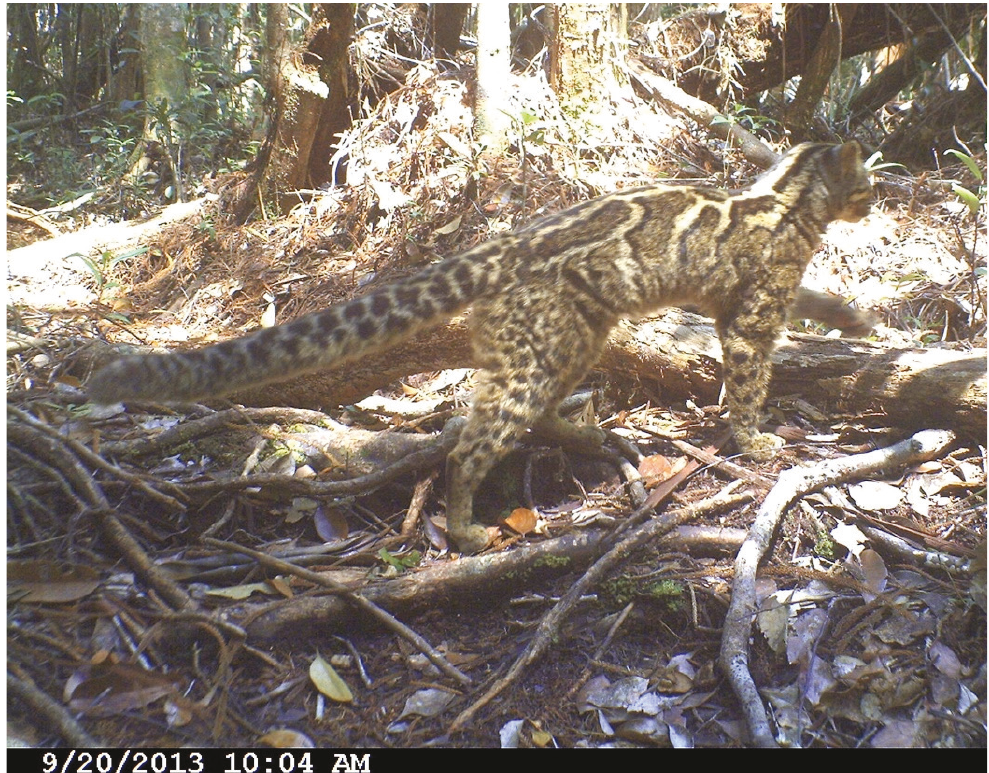
Image 2. Marbled Cat Pardofelis marmorata in Sebangau Forest, Central Kalimantan, Indonesian Borneo. © Borneo Nature Foundation, 20 September